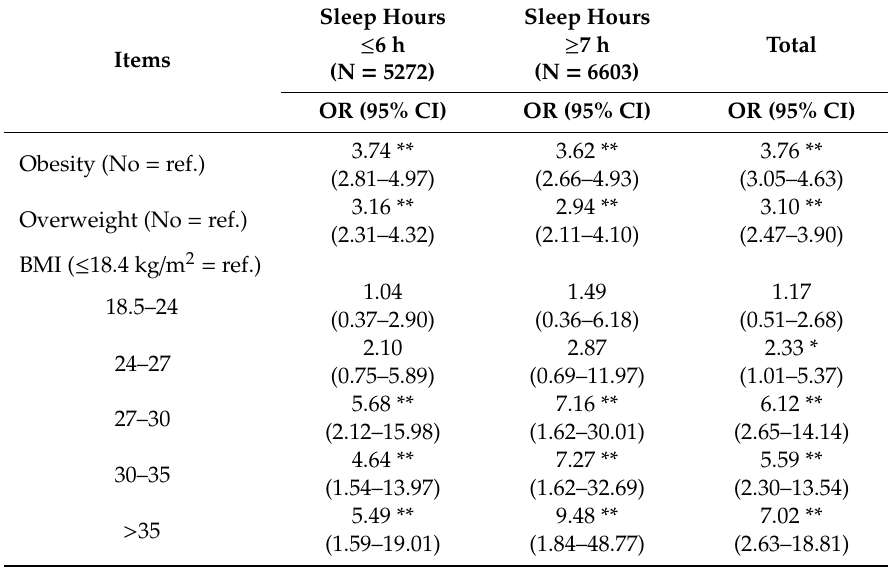
Table 5. T2DM associated with obesity, overweight, and BMI based on sleep duration during the workday using multiple logistic regression adjusted for gender, age, smoking, alcohol consumption, and betel nut